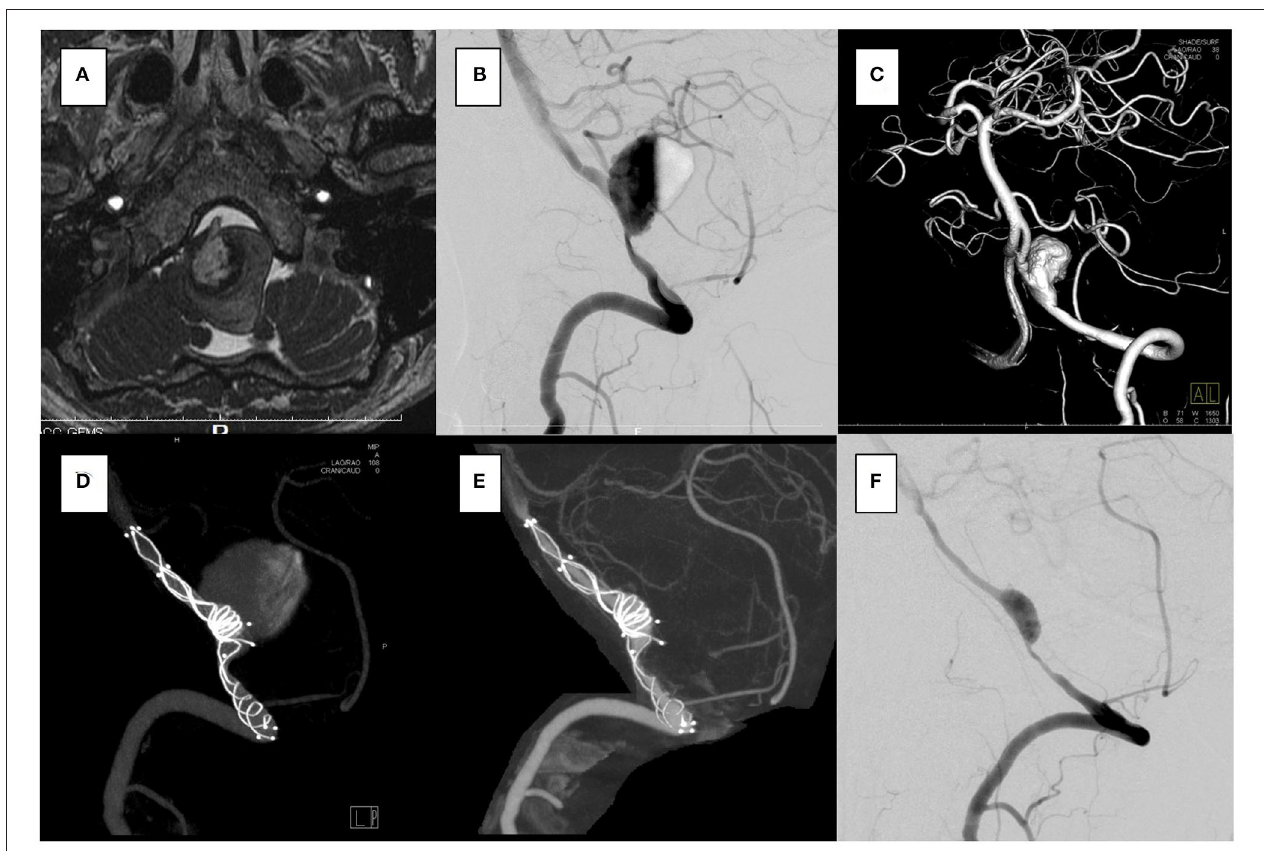
FIGURE 4 | In the case 3, the patient presented with left hemiparesis. The brain stem was compressed by a giant partially thrombosed vertebral artery aneurysm. (A–C) Overlapping stents with double low-profile visualized intraluminal support (LVIS) were placed (4.0 × 22mm, 4.5 × 32mm). The first stent was shortened when a micro catheter was advanced to the distal end of the vertebral artery, but it covered the aneurysm orifice. (D) After 6 months, the follow-up angiography showed that the aneurysm was almost closed off. (E,F) No recanalization was seen for 1